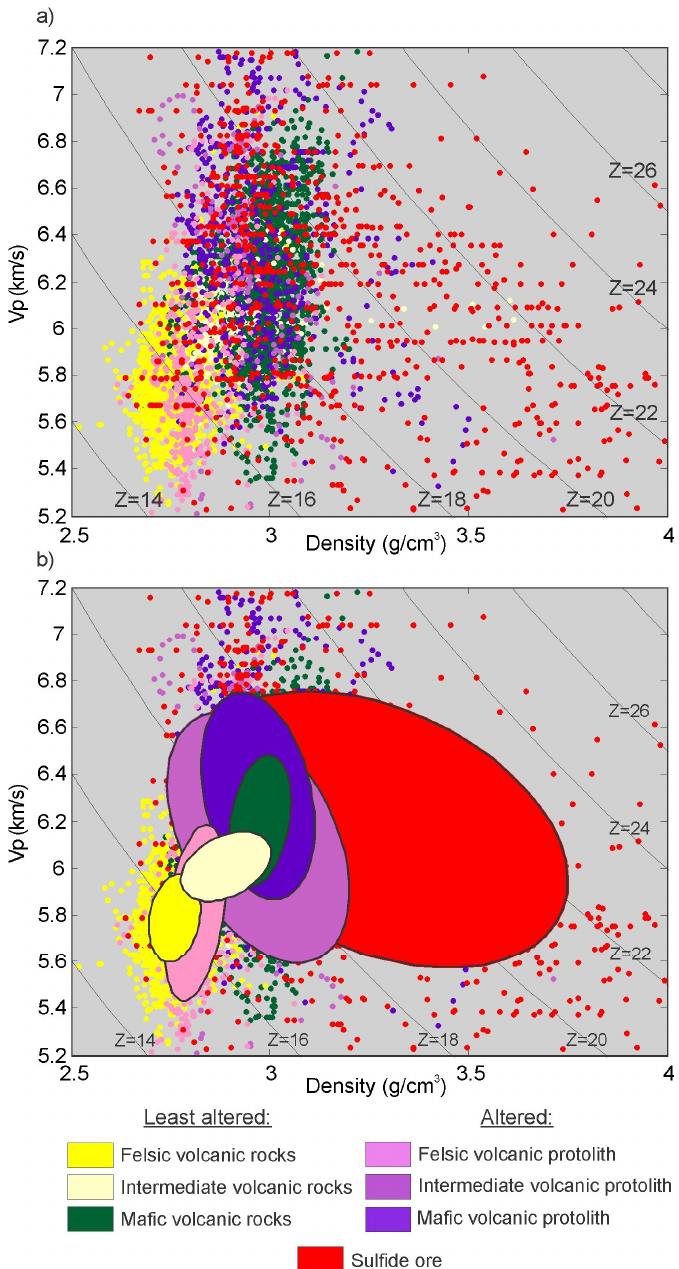
Figure 3. P-wave velocity ( V p) and density wireline log data of the main lithofacies units intersected in ten drill holes. ( a ) V p-ρ plot of wireline log measurements; ( b ) as (a), with the overlay of ellipses defined by the principal component analysis of V p and ρ for each lithofacies unit, with the minor and major axes representing one standard deviation from the mean. The mafic-intermediate lithofacies were defined by Zr/Ti < 0.017, the intermediate lithofacies by 0.017 <= Zr/Ti < 0.030, and the felsic lithofacies by Zr/Ti >= 0.03. Ore, including disseminated, vein-type, near solid, and massive types of sulfide mineralization was based on drill log descriptions from Hudbay Minerals [4]. Lines of constant acoustic impedances (Z) in kg/m −2 s −1 × 10 −6 are also shown on this figure. In addition to the V p- ρ lithofacies plot, the relationships between seismic rock property logs and alteration indices, computed from the co-registered whole rock geochemical analyses, were analyzed. These alteration indices included the Ishikawa index ( AI ) and chlorite–carbonate–pyrite (CCPI)